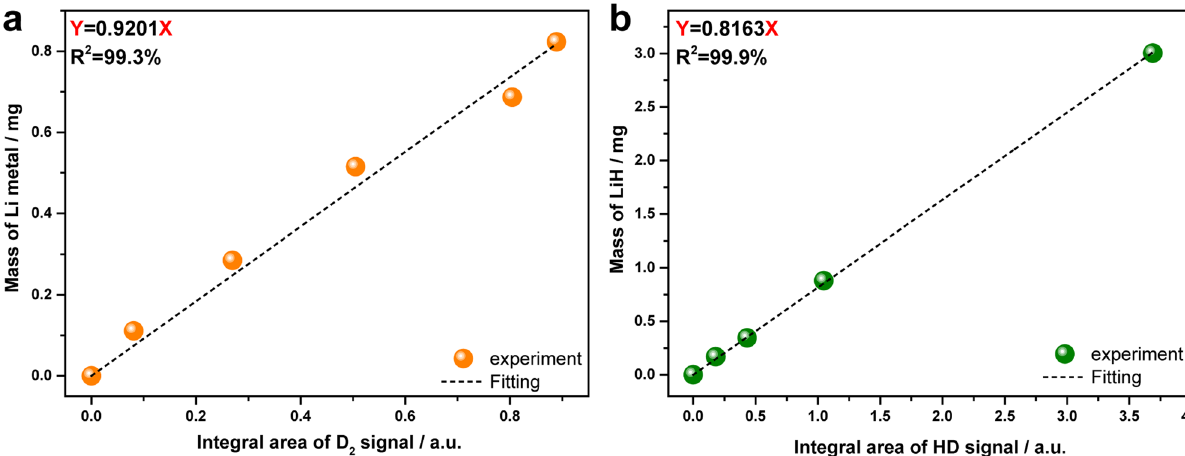
Fig. 3 The quantitative titration standard curves. a The calibration curve of mass of Li metal and corresponding integral area of D 2 signal. b The calibration curve of mass of standard LiH and corresponding integral area of HD